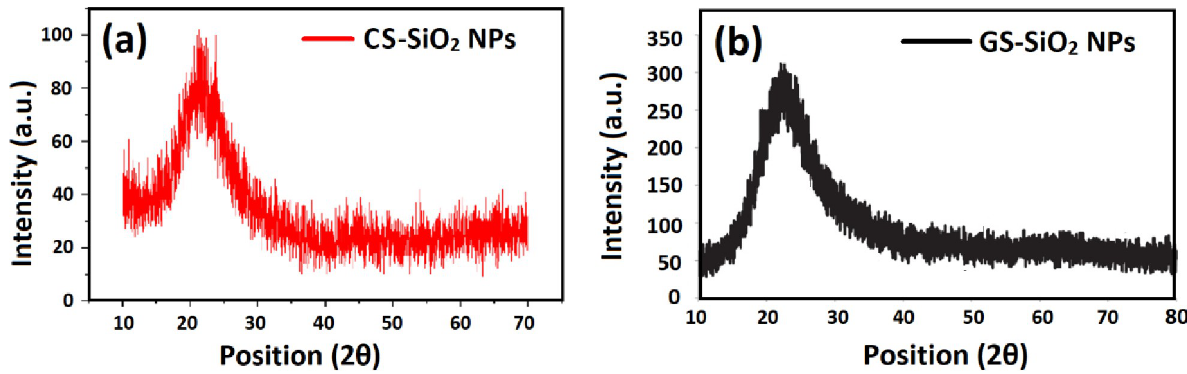
Fig 5. X-ray diffraction spectra of (a) CS-SiO 2 NPs and (b) GS-SiO 2 NPs.